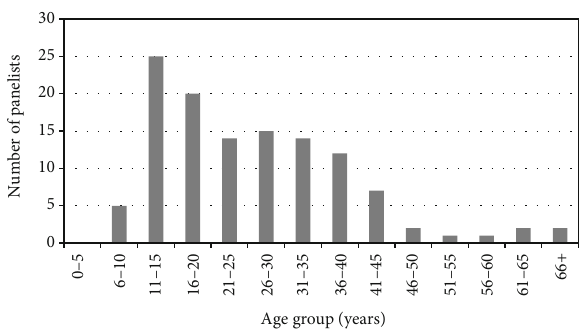
Figure 5: Age distribution of panelists.